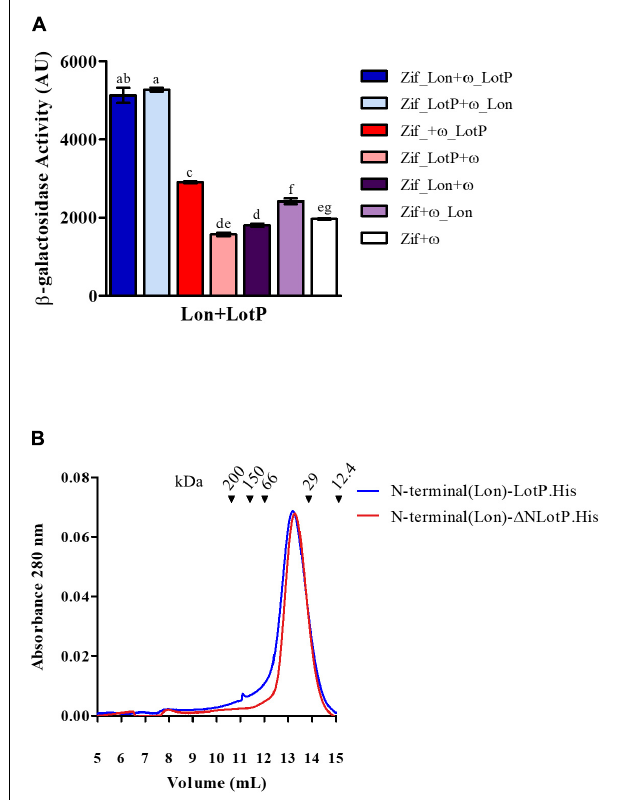
FIGURE 5 | Lon-LotP interactions and analysis of Lon’s N-terminal. (A) Interaction between LotP and Lon protease. β -Galactosidase activity was determined using Escherichia coli strain KDZif1DZ as a reporter strain, transformed with the different construction of the plasmid pACTR-AP-Zif (Zif) and pBRPG- ω ( ω ). Assays were performed at different stages of exponential growth (OD 600 = 0.3, 0.6, 0.9), while only OD 600 = 0.9 is shown. β -Galactosidase activity is shown as the average ± SD in arbitrary units (AU) from biological triplicates. Variance was calculated by one-way ANOVA with a Tukey’s post hoc test, p = 0.05. Significant difference between two samples is denoted by different letters. (B) Purified N-terminal(Lon).LotP.His (blue) and N-terminal(Lon)- (cid:49) NLotP.His (red) proteins analyzed by size-exclusion chromatography using a Superose 12 column. The purified proteins were separate according to its native molecular size. The elutions were monitored continuously at 280 nm, and the graphic shows the signal at the different elution